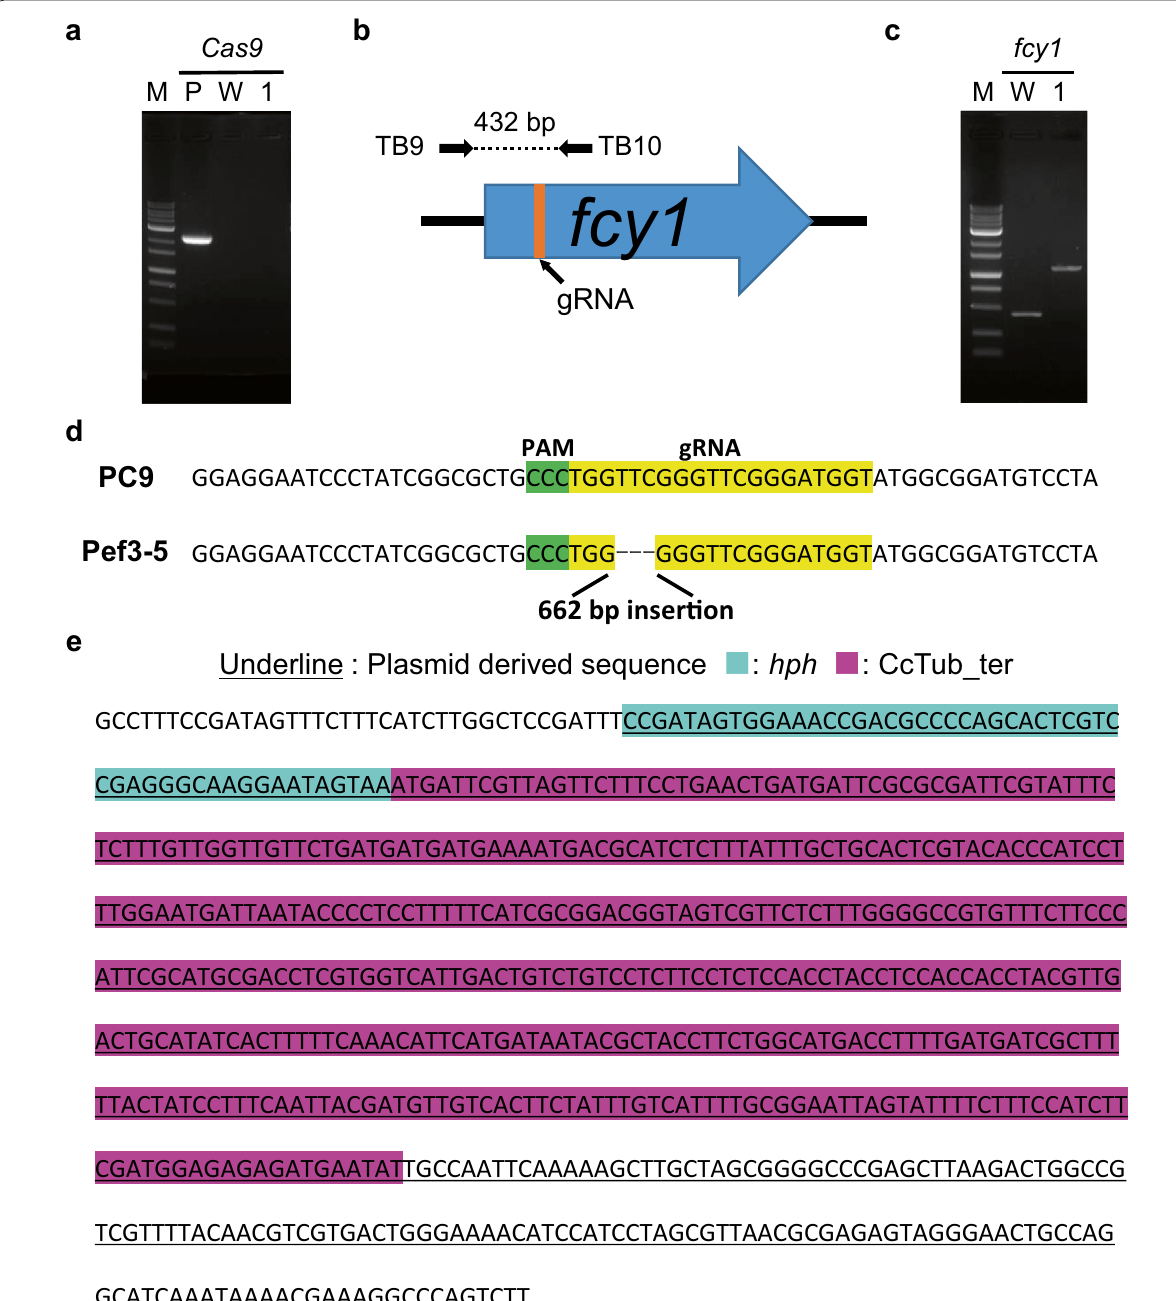
Fig. 3 Confirmation of transient Cas9 expression and genome editing. a PCR amplification of cas9 gene fragment using primer sets Cas9check_F2 and Cas9check_R2. Lane M, 1-kb ladder (Nippon gene); lane P, pCcPef3-126-fcy1sg2 (positive control); lane W, parental strain PC9 (negative control); lanes1, Pef3-5. b A schematic diagram of the fcy1 loci in the PC9 parental strain with gRNA recognition sites. The dash lines indicate the region amplified by genomic PCR. Black arrows display the primer pairs used for the PCR experiments and Sanger sequencing. c PCR amplification of a target site of gRNA in the fcy1 using primer set TB9 and TB10. Lane M, 1-kb ladder (Nippon gene); lane W, parental strain PC9; lanes1, Pef3-5. d DNA sequencing to identify mutations of fcy1 in Pef3-5 strain. For highlights in the nucleotide sequence: yellow shades indicate gRNA, green shades indicate a protospacer adjacent motif (PAM) sequence, and dash lines indicate deletion by insertion of a plasmid sequence. e Insertion sequence in fcy1 locus of Pef3-5 strain revealed by Sanger sequencing. For highlights in the nucleotide sequence: blue shades indicate a sequence derived from hph , magenta shades indicate a sequence derived from CcTub_ter, and under lines indicate sequence derived from